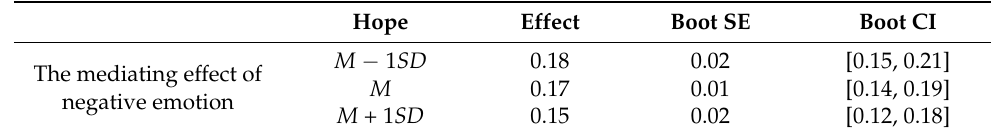
Table 4. The mediating effect of negative emotion at different levels of hope.